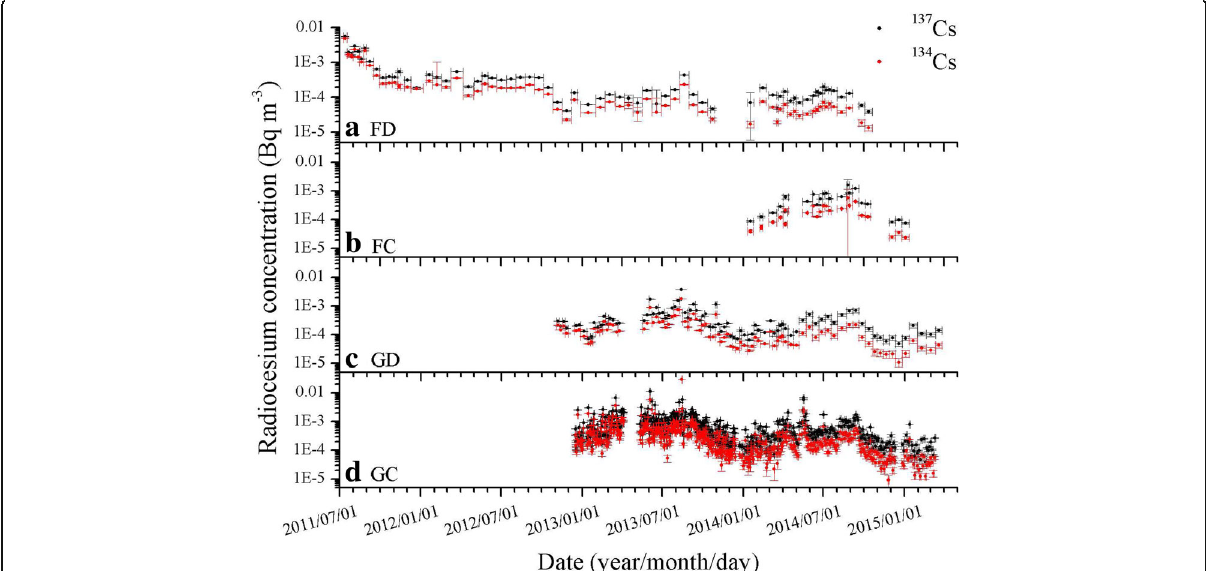
Fig. 2 Activity concentrations of 134,137 Cs (Bq m − 3 ) measured at the FD, FC, GD, and GC sites in the Fukushima prefecture in July 2011 to March 2015. These results show high concentrations in late spring, summer, and early autumn and low concentrations in winter and early spring at all of the presented observation locations